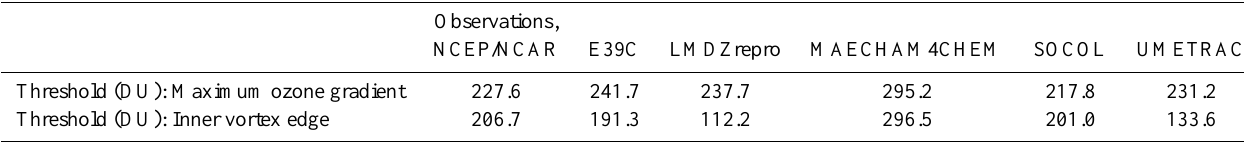
Table 3. Total column ozone thresholds for observations and the 5 CCMs. The thresholds were calculated in two ways as described in the text based on 1995–1999 averages (also see Fig.